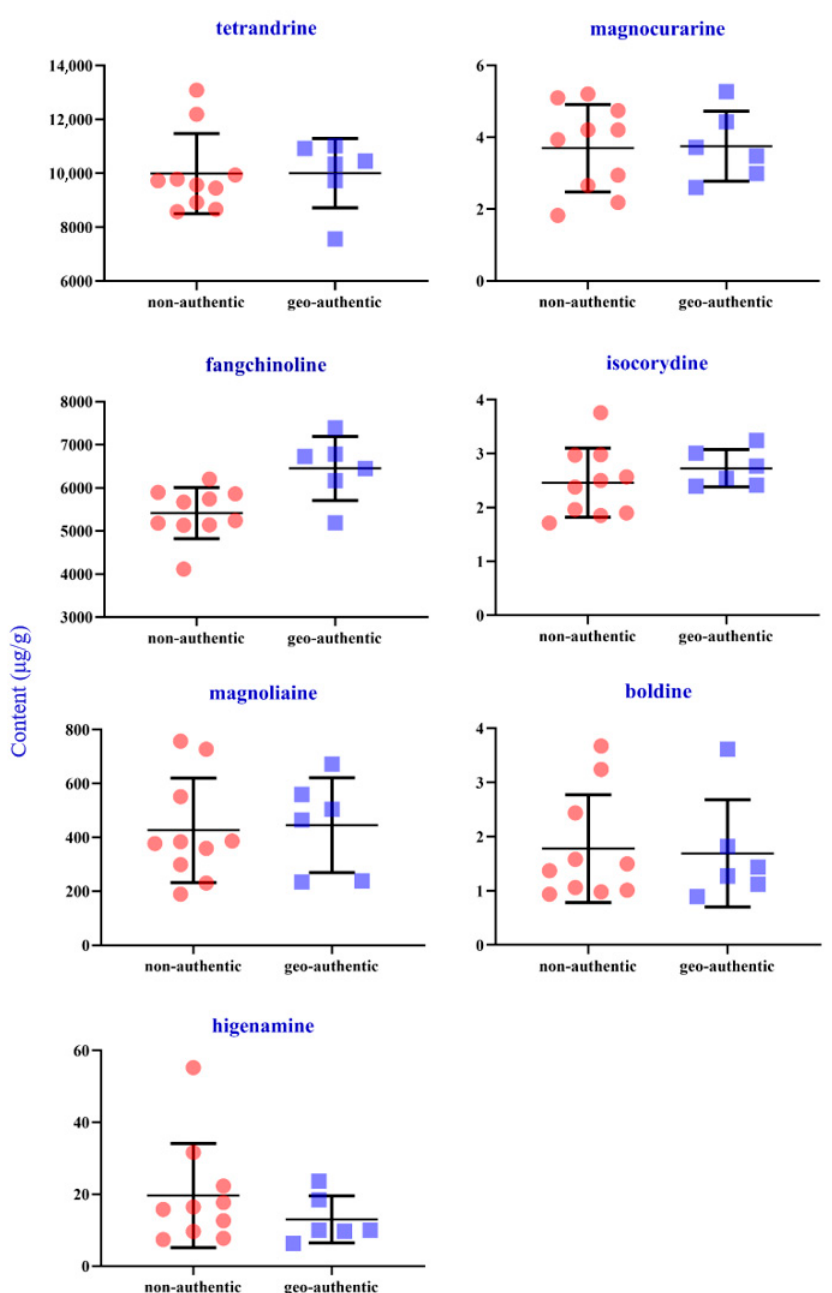
Figure 5. Contents of seven alkaloids of S. tetrandra from non-authentic origins and geo-authentic origins.